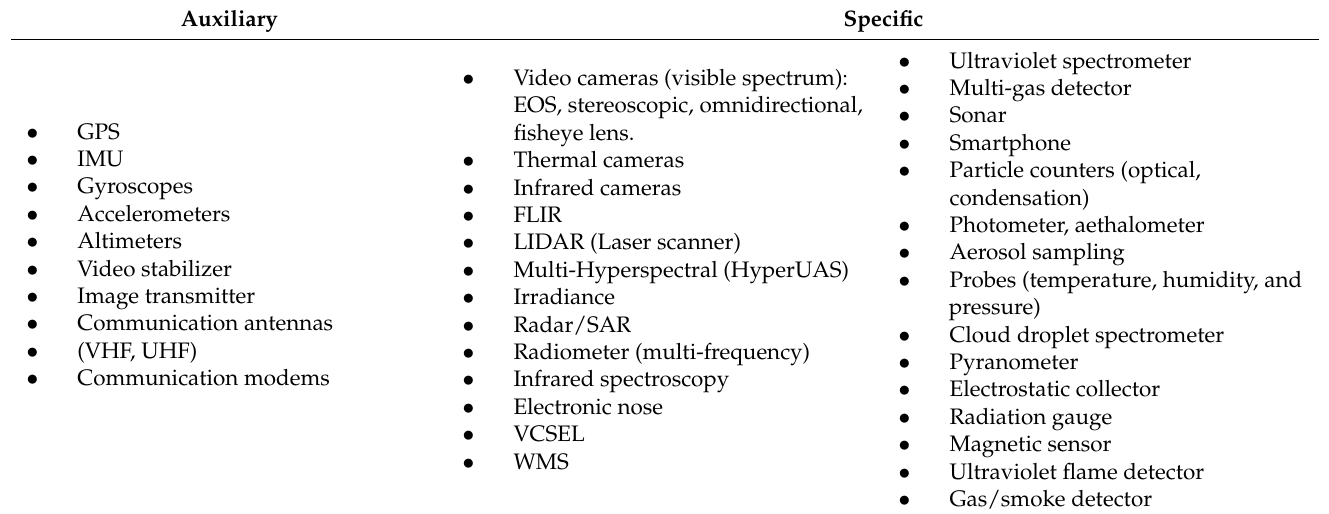
Table 5. UAV onboard sensors: auxiliary and specific